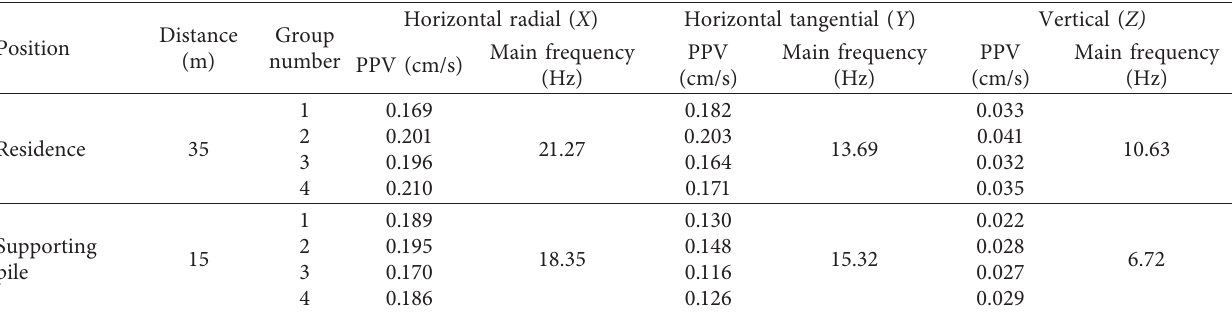
Figure 5: The characteristic curve of blasting vibration response of seismic wave: (a) the monitoring point in the residence and (b) the monitoring point in the supporting Table 2: The PPV and main frequency of the on-site monitored data.